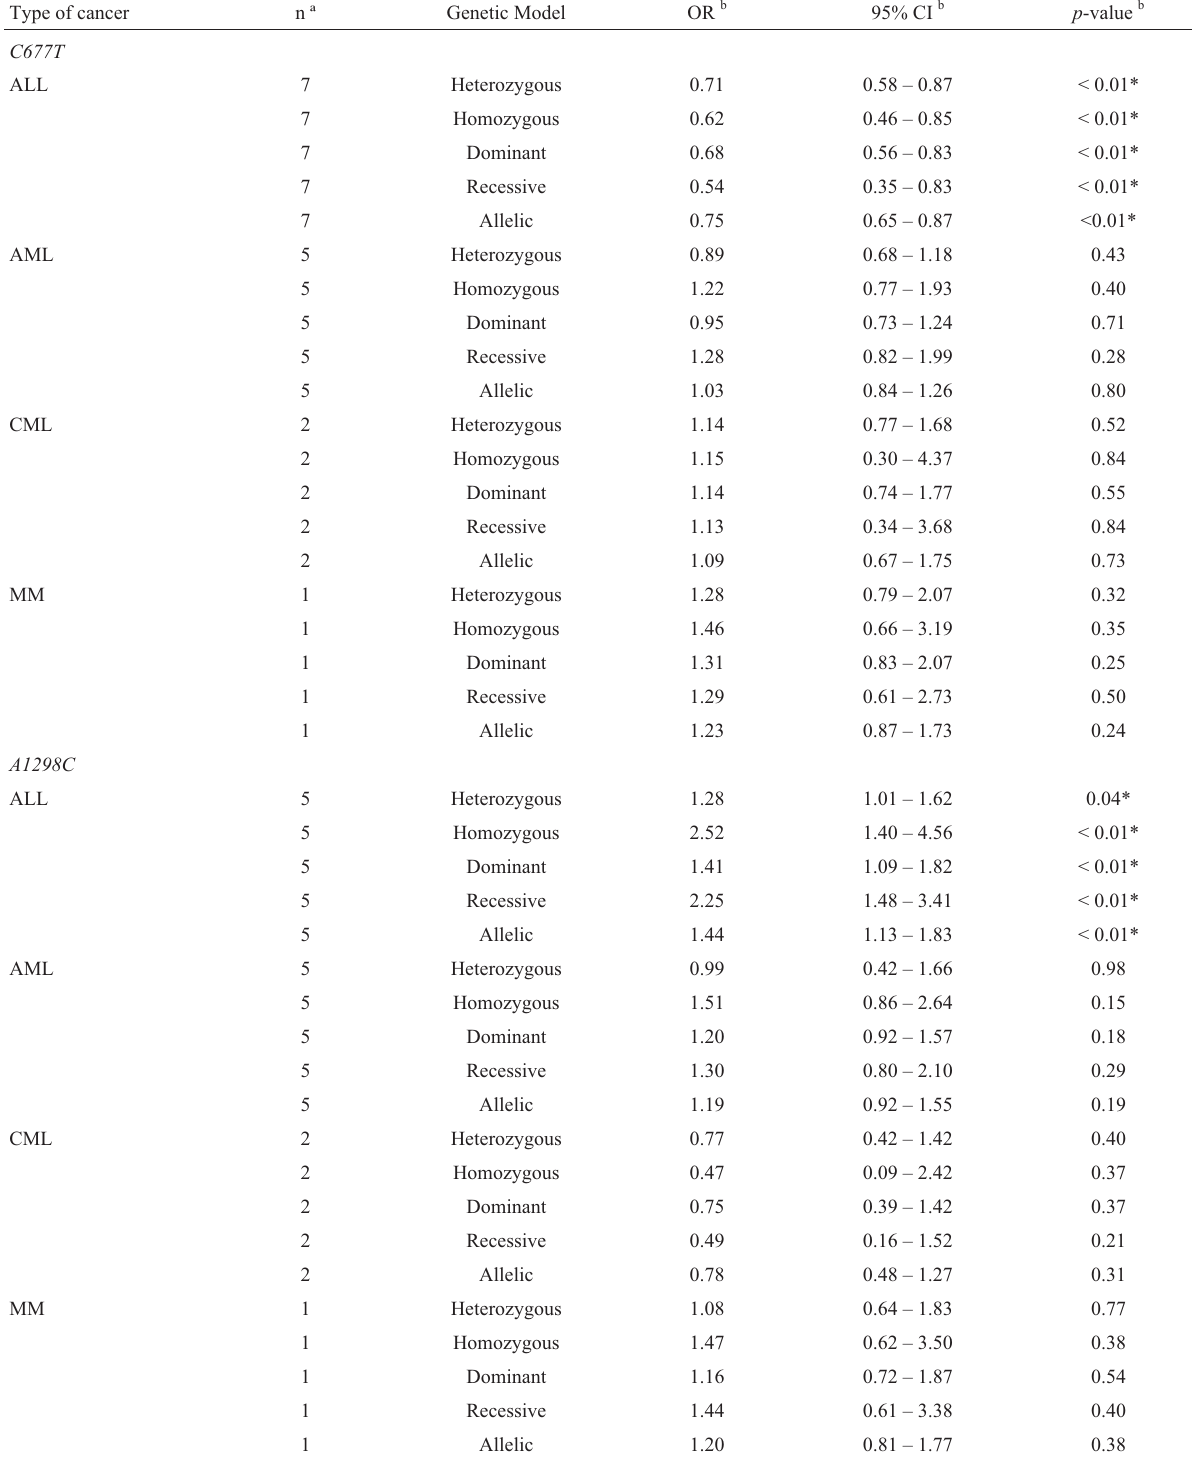
Table 3 - Association between the MTHFR polymorphisms and developing hematological cancers, stratified by type of cancer. Type of